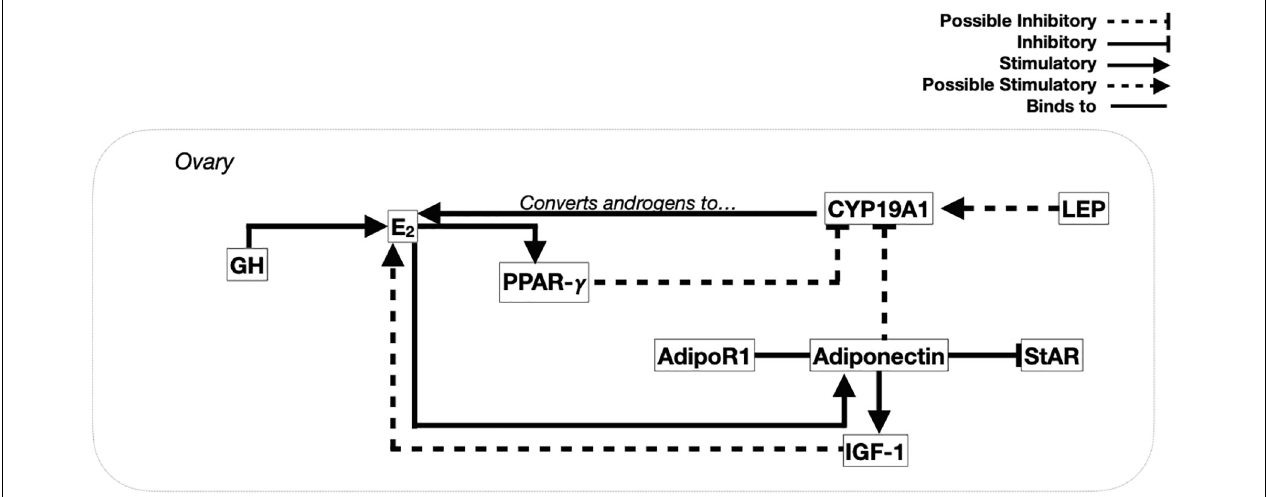
FIGURE 2 | Proposed integration of metabolic factors with maturation of ovarian follicles. In the ovary, growth hormone (GH) binds to the growth hormone receptor first in the theca cell layer of prehierarchal follicles, then in the granulosa cell layer during growth of hierarchical follicles. In prehierarchal follicles, GH stimulates the production of estradiol (E 2 ) from the theca layer, further stimulating the early stages of follicular recruitment and development. Once E 2 is produced, it stimulates the expression of peroxisome proliferated-activated receptor gamma (PPAR- γ ), which in turn has the ability to inhibit E 2 production, forming a negative feedback loop. Prior to activation of the ovary, adiponectin mRNA levels increase in the theca layer allowing binding of adiponectin to its receptor (AdipoR1) present in both cell layers. Adiponectin then down-regulates steroidogenic acute regulatory (StAR) protein and insulin-like growth factor 1 (IGF-1), which are hypothesized to stimulate E 2 synthesis in the absence of gonadotropins. Leptin (LEP), upon binding to its receptor (LEPR) mostly present in the granulosa layer, may stimulate CYP19A1 to increase E 2 production while reducing testosterone. Meanwhile, as E 2 is able to stimulate adiponectin expression in the theca layer and, with adiponectin able to inhibit the production of E 2 , a local negative feedback system between the two has been